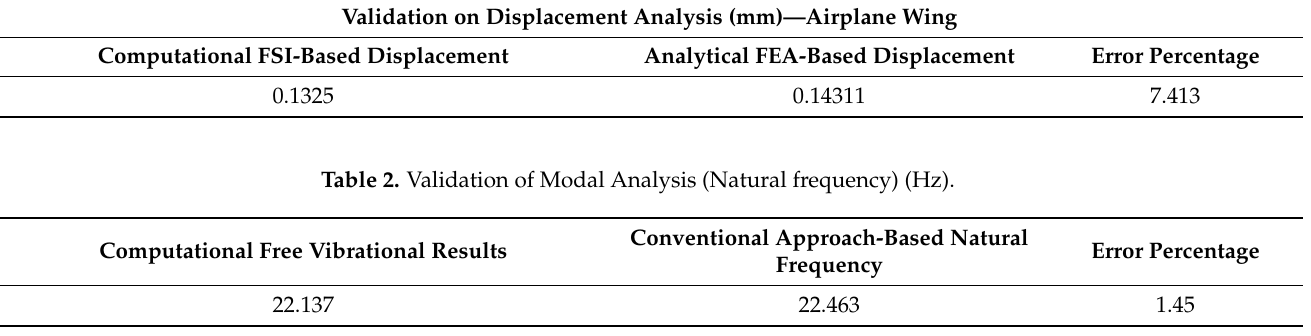
Table 1. Comparative analysis of validations.